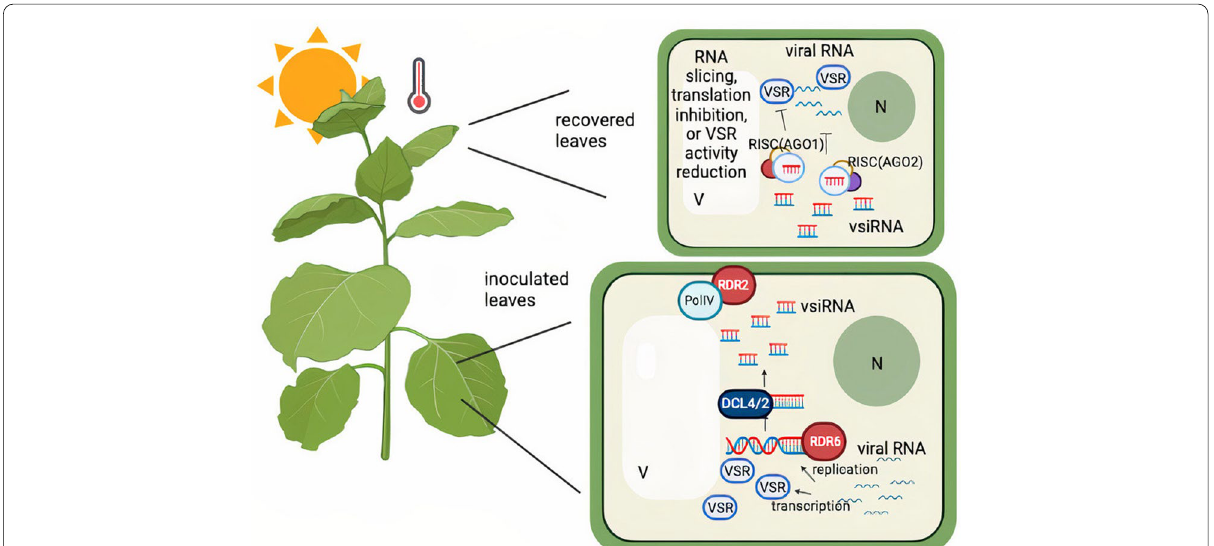
Fig. 1 Model depicting the concept of symptom recovery at elevated temperature. Higher temperatures facilitate viral RNA replication at early stages of infection in inoculated leaves. An early onset of RNAi is triggered by the higher accumulation of viral RNAs, leading to an increased accumulation of viral siRNAs (vsiRNAs). Symptom recovery occurs when secondary siRNAs travel to non‑inoculated leaves to trigger RNA slicing, translational inhibition or lower the activity of viral RNA silencing suppressors (VSRs). Components, such as RNA‑ dependent RNA polymerase 6 (RDR6), RDR2, DICER‑LIKE 2 (DCL2), DCL4, AGRONAUTE 1 (AGO1), AGO2, and PolIV are involved in this mechanism. V